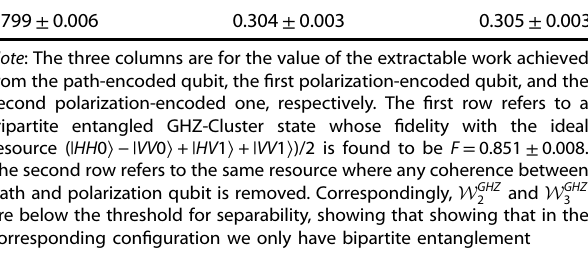
Table 1. Extractable work in bits for the three permutations of roles in the protocol for extractable work-based inseparability evaluated using a GHZ-Cluster resource W GHZc